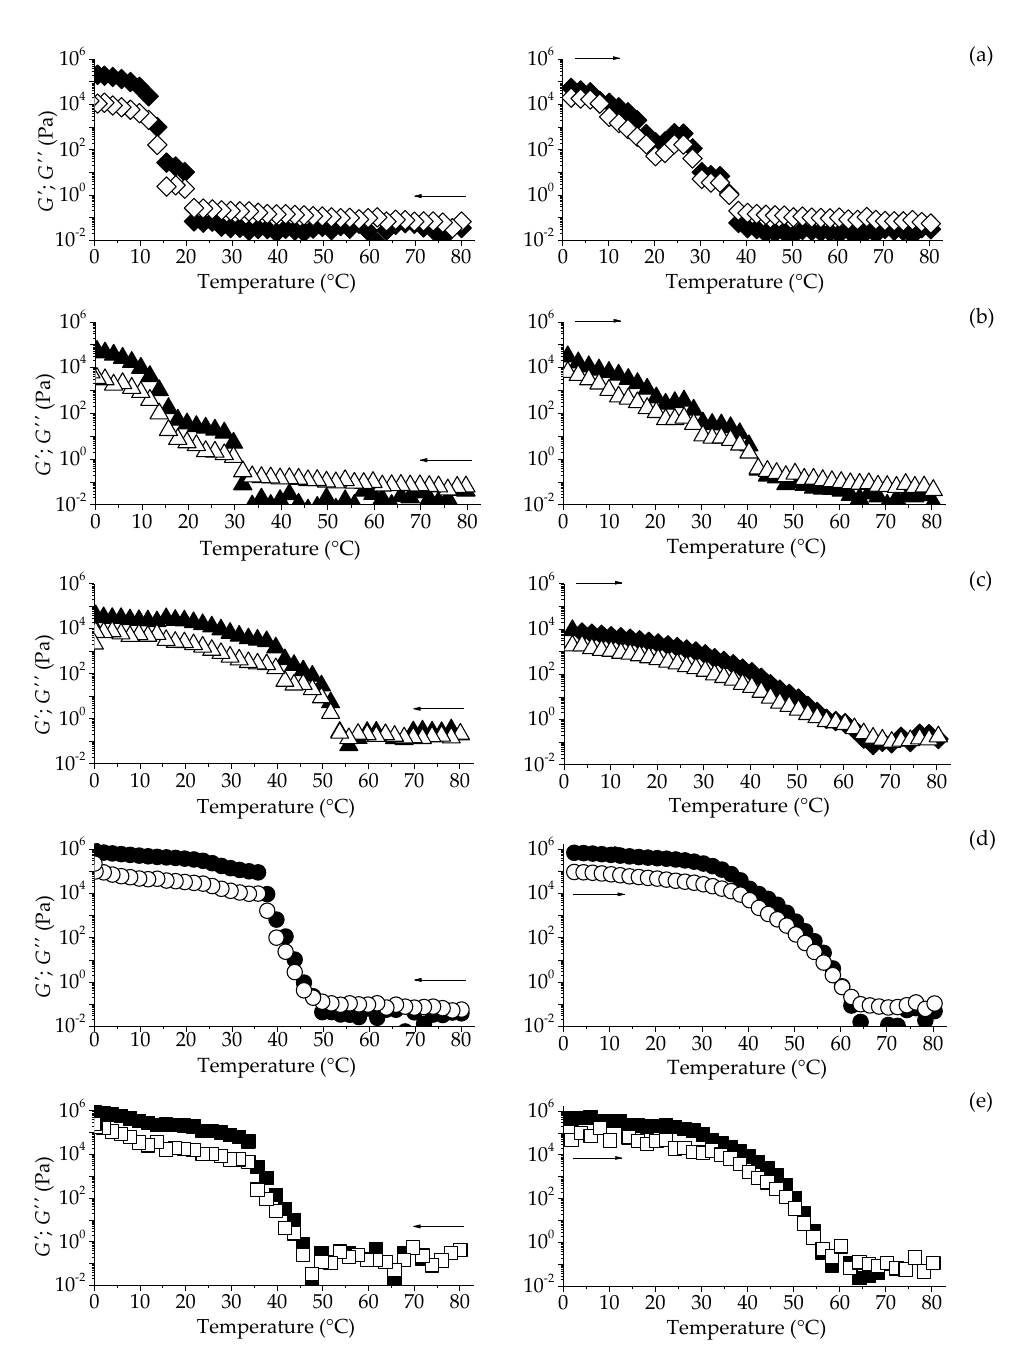
Figure 3. Temperature sweep of GMS0:100BEW ( a ), GMS25:75BEW ( b ), GMS25:75SWH ( c ), GMS50:50SWH ( d ), and GMS75:25SWH ( e ). Cooling (left) and heating steps (right). Solid symbol ( G ’ ) and open symbol ( G ’’ ).